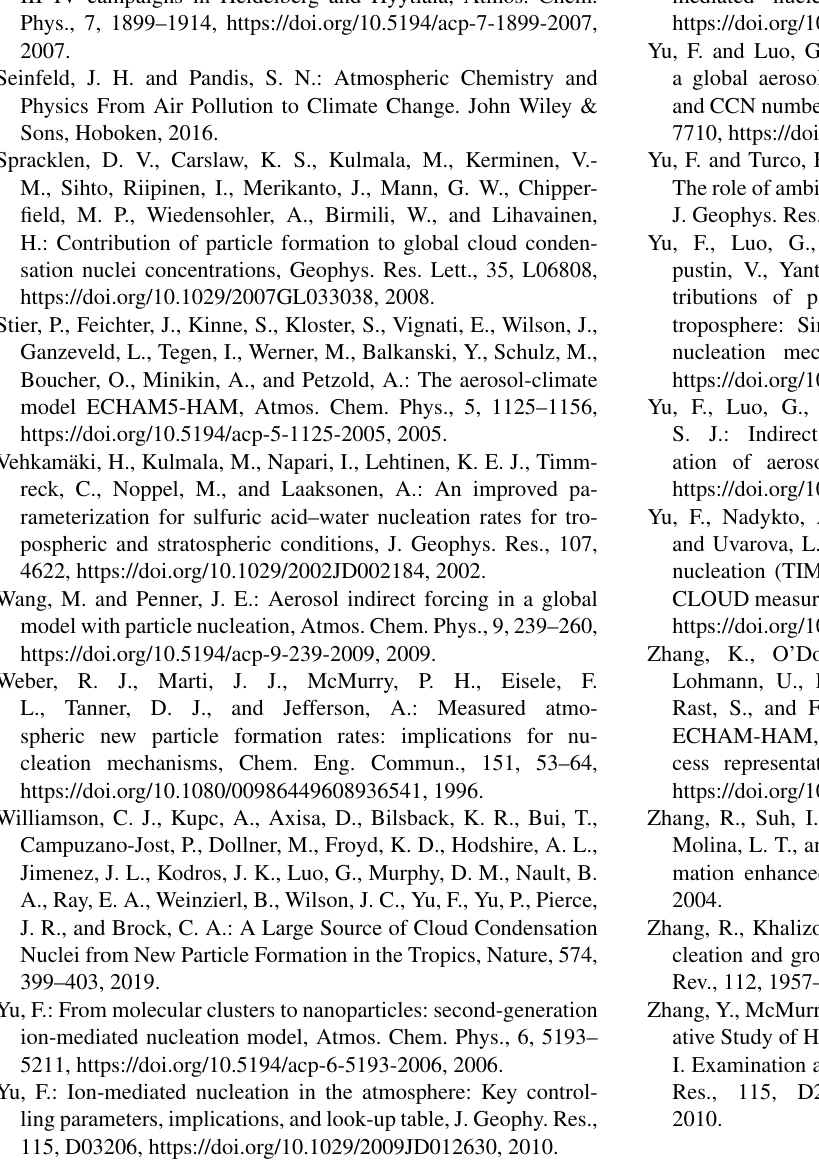
Yu, F.: Lookup tables for H 2 SO 4 -H 2 O binary and H 2 SO 4 -H 2 O-NH 3 ternary homogeneous and ion- mediated nucleation (Version 1.0.0) [Data set],